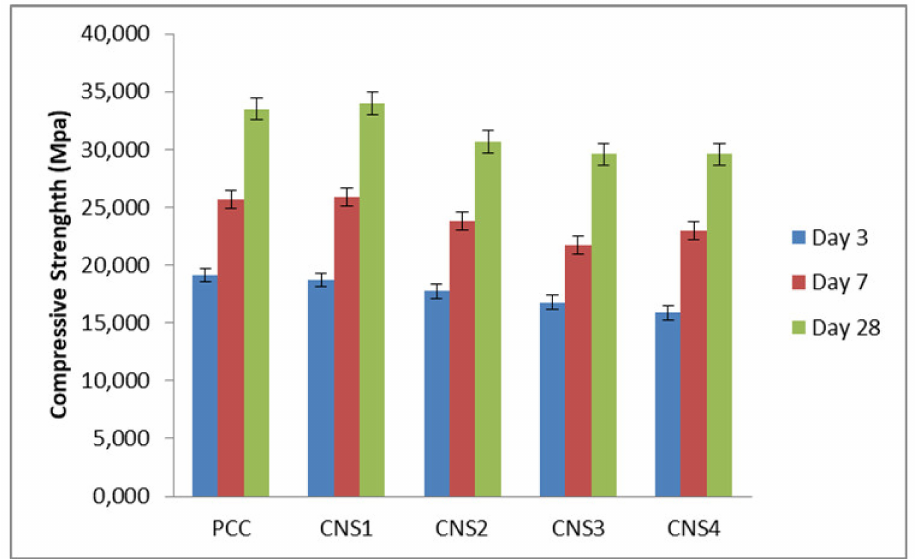
Figure 10. The relationship between the percentage of Napa soil ( n = 5) and compressive strength of the